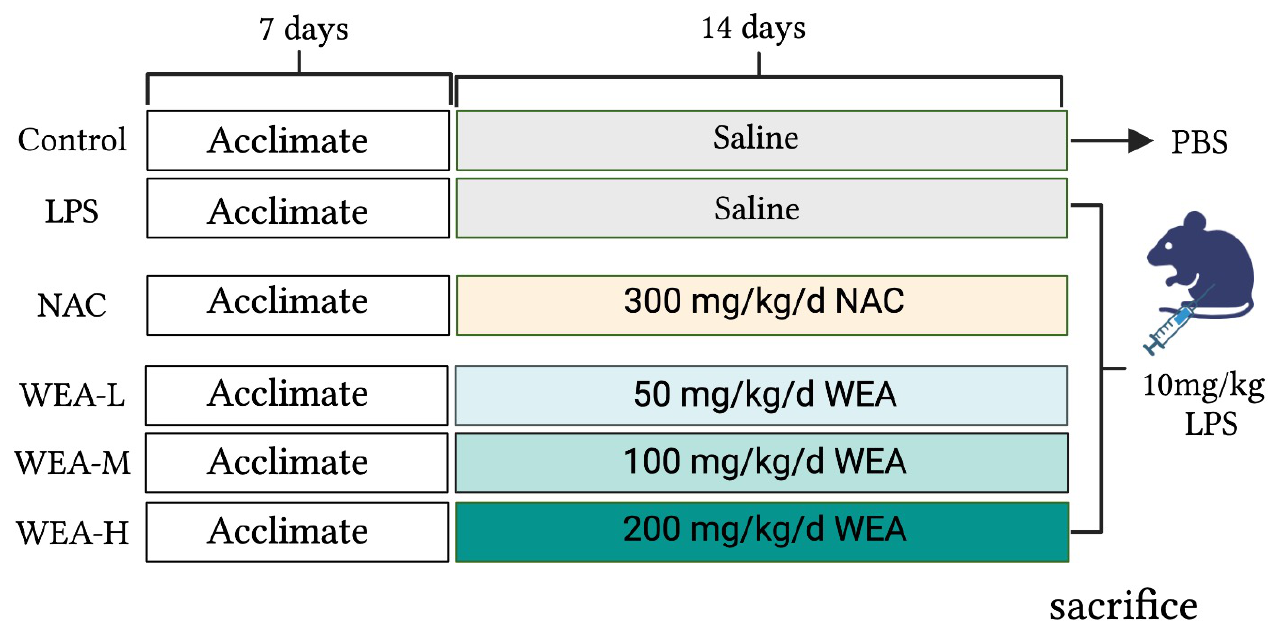
Figure 1. Study design. LPS, lipopolysaccharide; NAC,